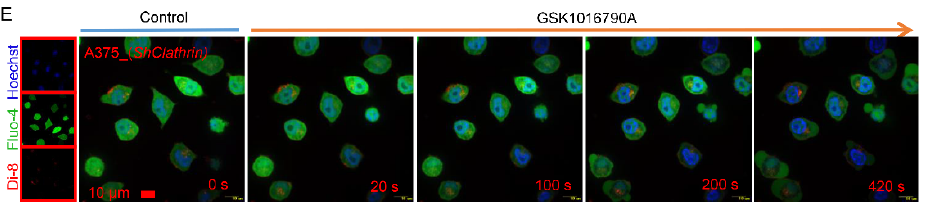
Figure 5. The folding & vesicle trafficking proteins aid in exocytosis. ( A ) Western blot of A375 cell (upon GSK1016790A by concentration gradient) lysates probed for the vesicle trafficking pro- teins of HSP90, dynamin1, clathrin (heavy chain), Rab3A, and EEA1, respectively. Target protein quantification was normalized to total protein. ( B ) Western blot of A375 cell with shTRPV4 (upon GSK1016790A by concentration gradient) lysates probed for the vesicle trafficking proteins of HSP90, dynamin1, clathrin (heavy chain), Rab3A, and EEA1, respectively. Target protein quantification was normalized to total protein. ( C ) Confocal spanning disk microscopic images of A375 cells with or without GSK1016790A (20 nM) addition immunostained for clathrin (heavy chain). Scale bar, 10 µ m. ( D ) Transmission electron microscopic images of A375 cells upon GSK1016790A (20 nM) application. The arrowhead points to clathrin structure. Scale bar, 100 nm. ( E ) Time-lapse of scanning disk confocal images of A375 cells with clathrin (heavy chain) knock-down with GSK1016790A (20 nM) administration. Data are presented as mean ± SD of at least three independent experiments, t -test, * p < 0.05, ** p < 0.01, *** p < 0.001, ns indicates no